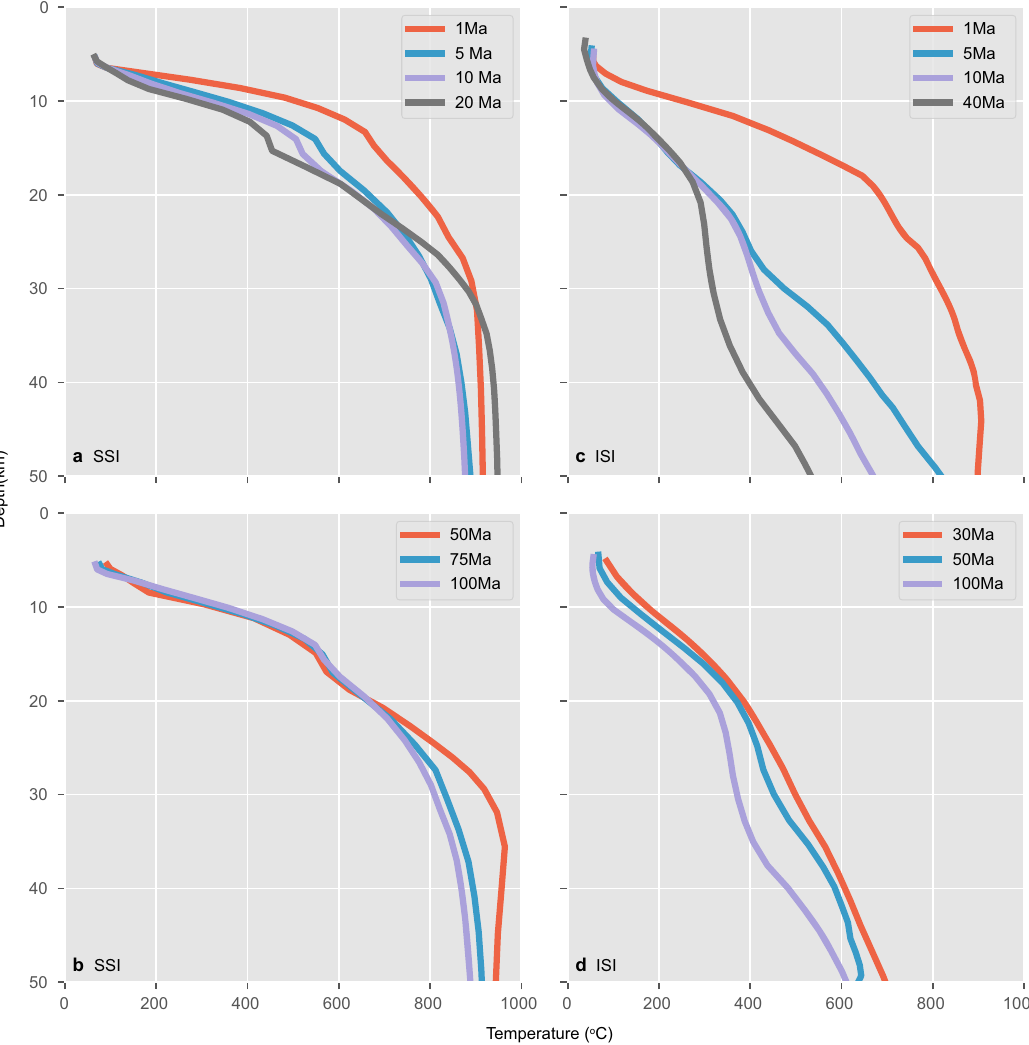
Fig. 4 Slab surface pressure – temperature path. Variation in the pressure – temperature path of a tracer along the slab surface at 10 km from the slab tip for (top panels) different overriding plate ages with a 100 Ma subducting plate and (bottom panels) different subducting plate ages with a 20 Ma overriding plate for the case of a , b spontaneous subduction initiation (SSI) and c , d induced subduction initiation (ISI),